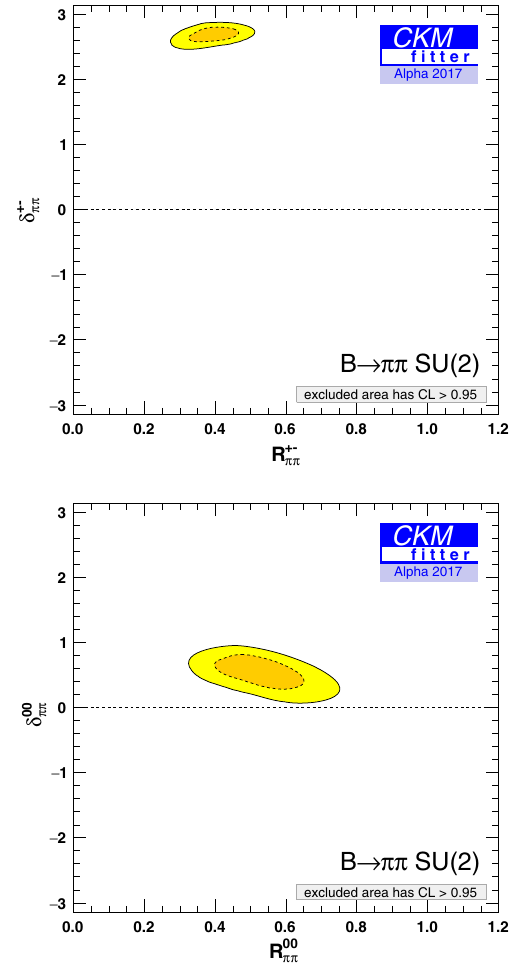
Fig. 20 68% ( dark area ) and 95% CL ( light area ) constraints on the modulus and phase for the penguin-to-tree ratio P ij / T ij = R ij e i δ ij for B 0 → π + π − ( top ) and B 0 → π 0 π 0 ( bottom